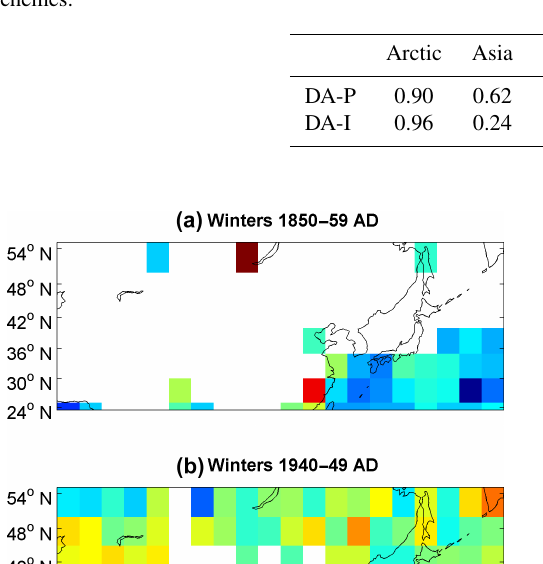
Table 2. Correlations between the NH continental mean temperatures from the DA analyses and the gridded instrumental data, for the two DA schemes.